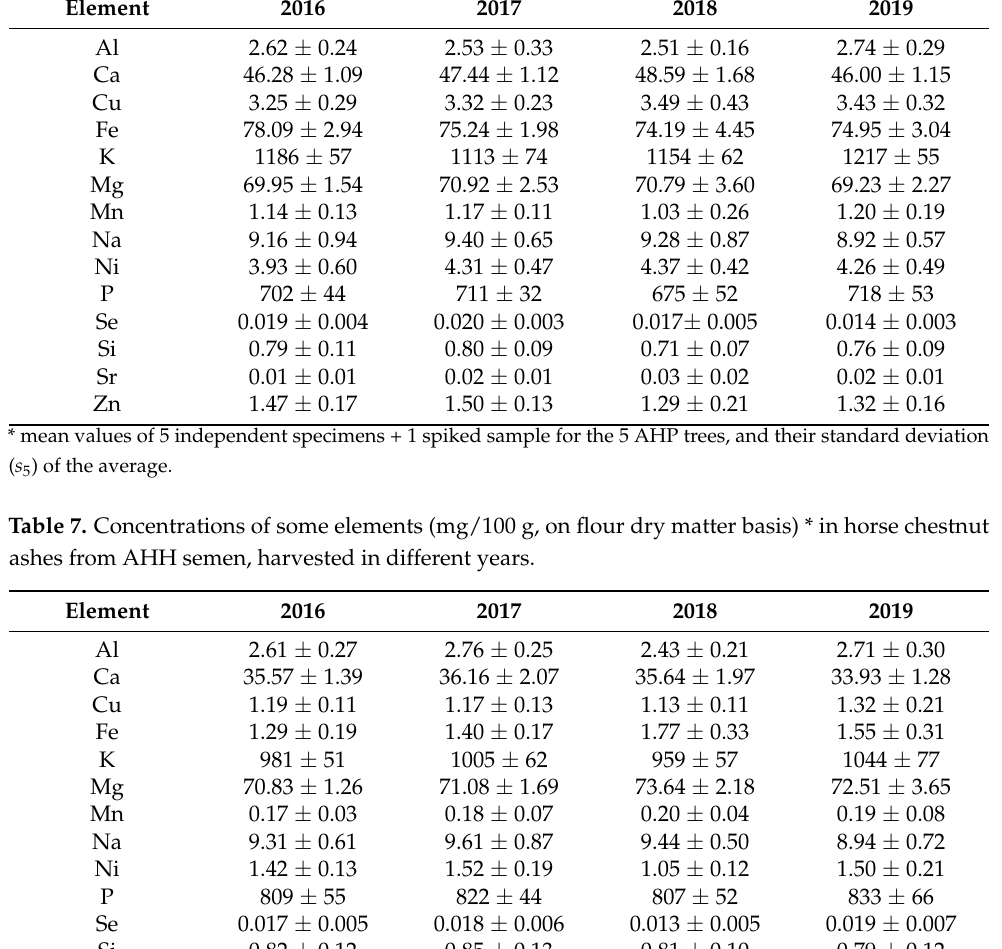
Table 6. Concentrations of some elements (mg/100 g, on flour dry matter basis) * in horse chestnut ashes from AHP semen, harvested in different years. Element